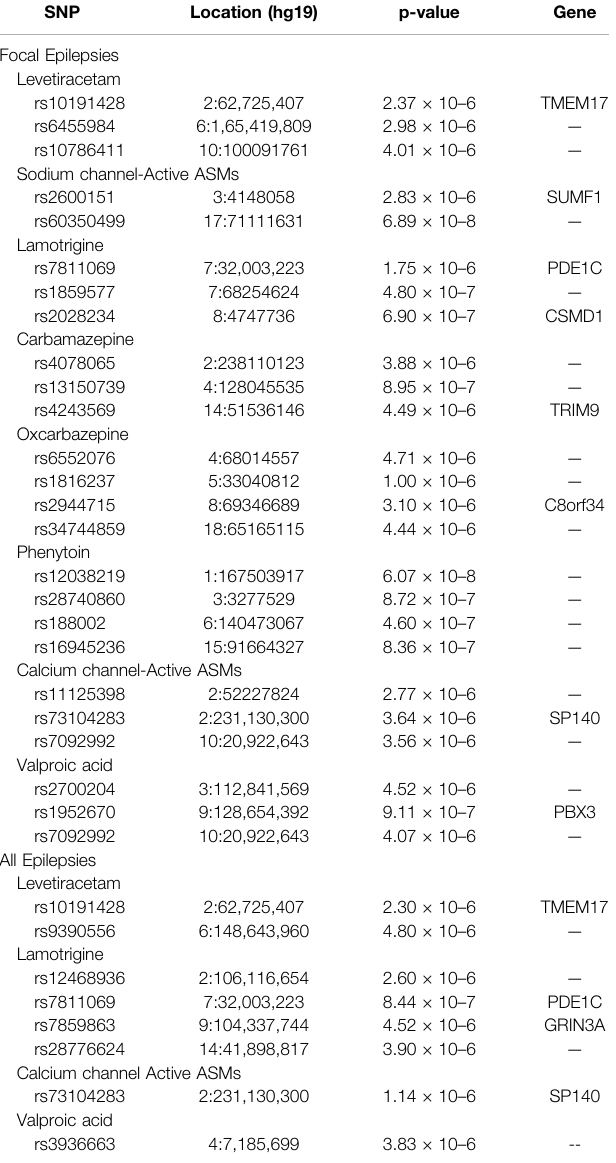
TABLE 2 | Top genome-wide association study results (p < 5 × 10 – 6) for ASM responder status SNP Location (hg19) p-value